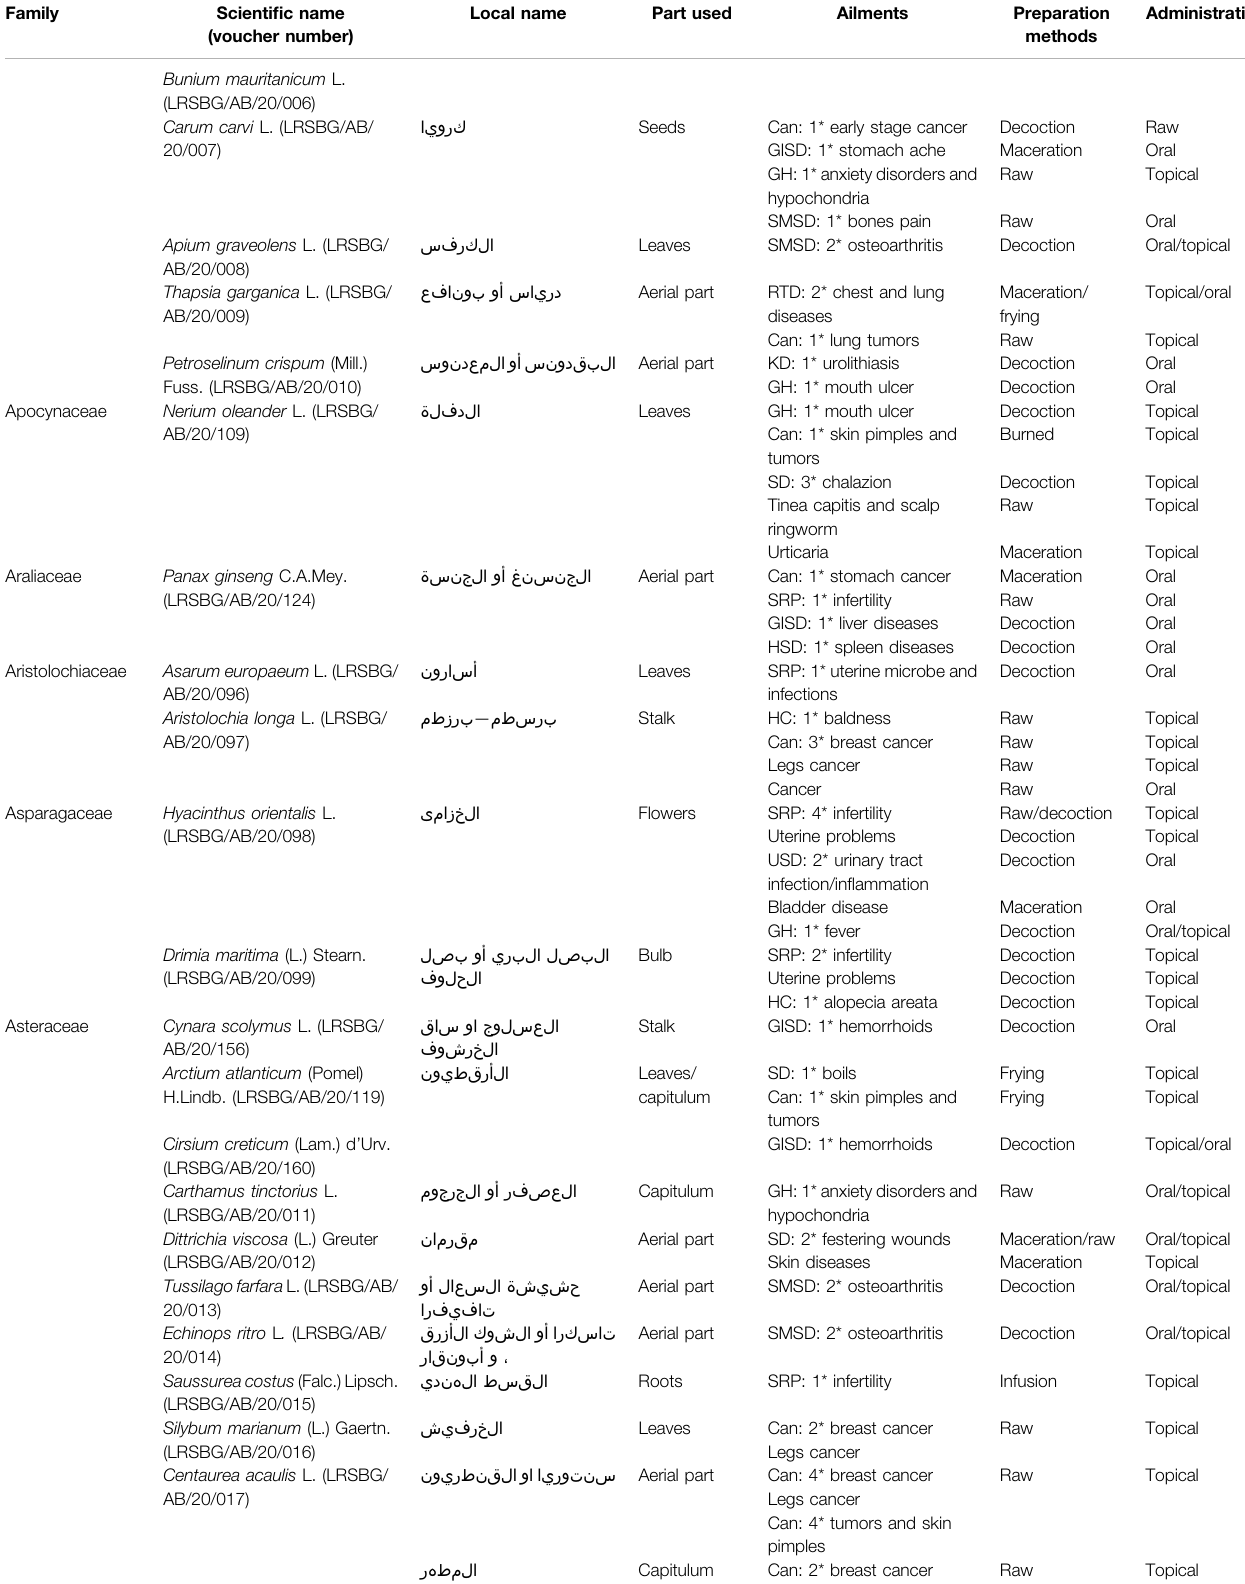
TABLE 7 | ( Continued ) List of medicinal plants used by traditional healers in the study